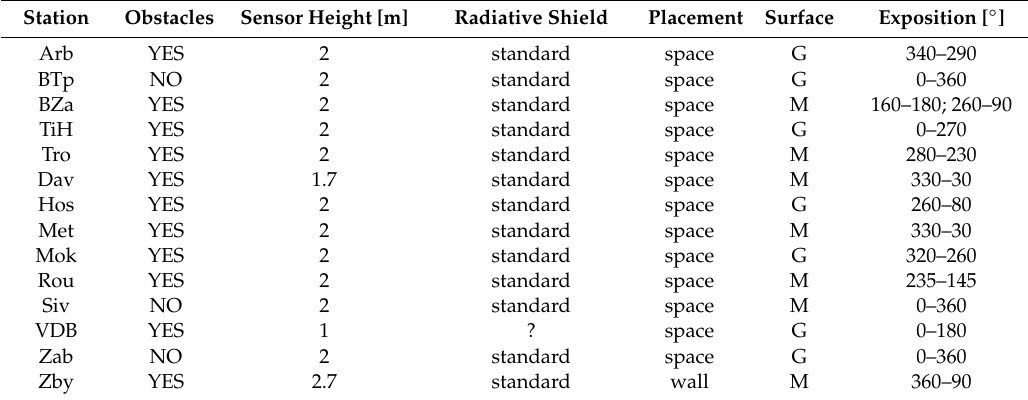
Table 2. Summary of parameters influencing the recorded air temperature data according to [2] and [32]. Station Obstacles Sensor Height [m] Radiative Shield Placement Surface Exposition [ ◦